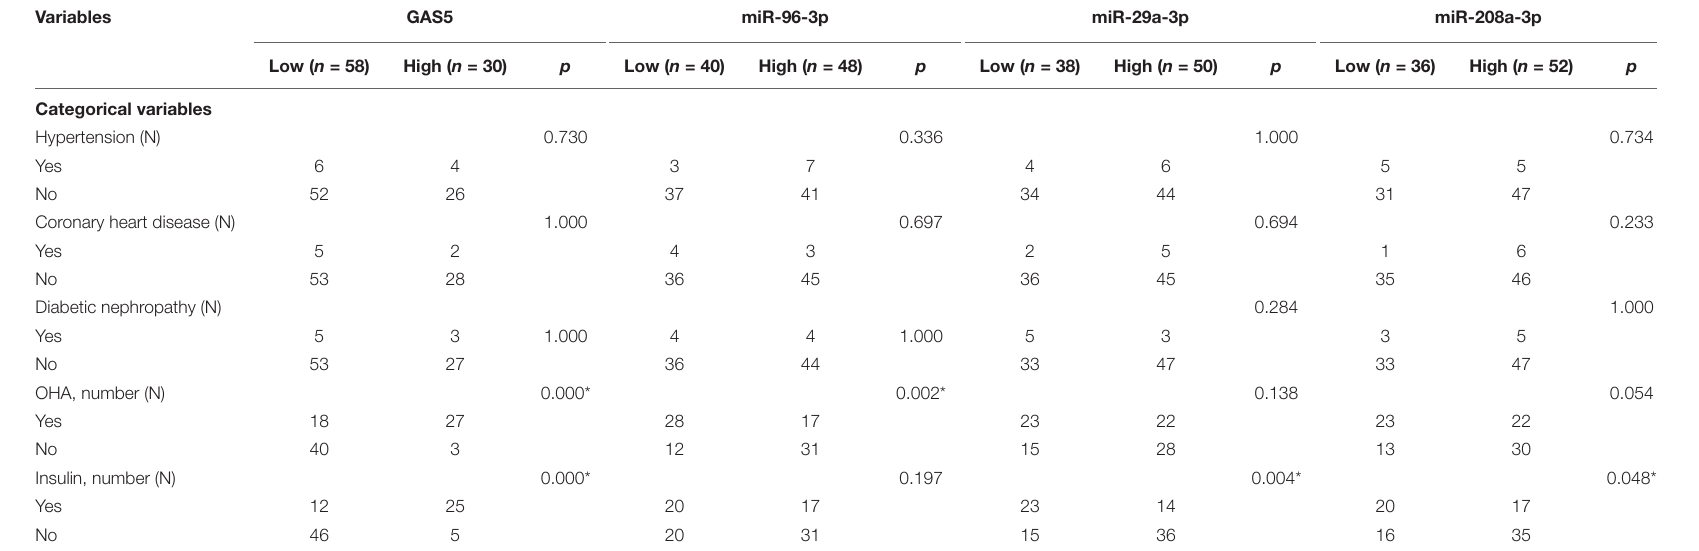
TABLE 3 | The association of GAS5, miR-96-3p, miR-29a-3p, and miR-208a-3p with categorical variables of patients with T2DM.